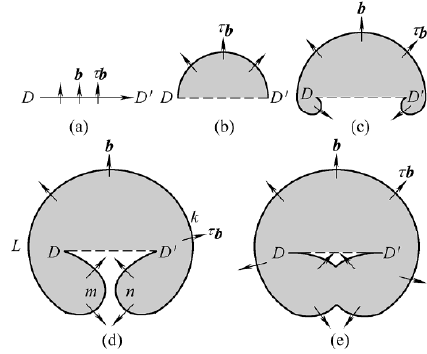
Figure 9. Frank-Read dislocation multiplication [22]: ( a )–( e ) the process of dislocation multiplication. In the figure, b is the Burgers vector and τ is the component of stress applied on the dislocation line